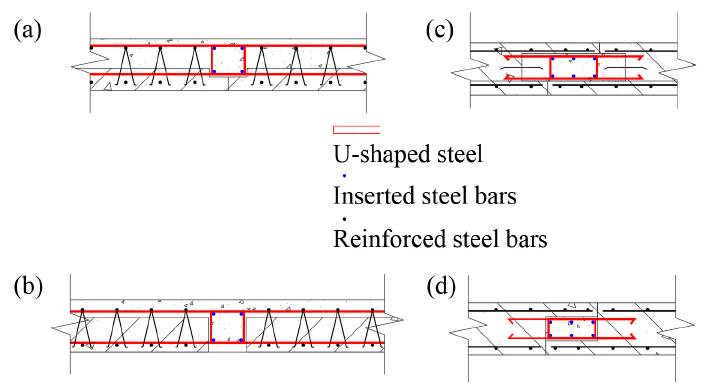
Figure A2. Four kinds of longitudinal connections: ( a ) between bottom plates; ( b ) between top plates; ( c ) between lateral walls; and ( d ) between middle walls.